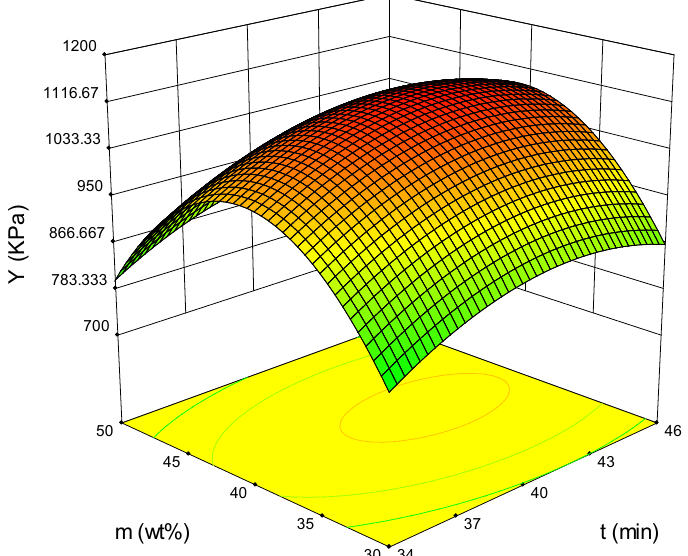
Figure 2. Response surface showing Y as a function of curing agent dosage (m) and curing time (t).